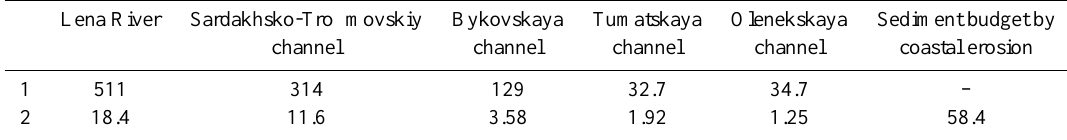
Table 1. Mean-annual water (1) (km 3 ) and sediment load discharge (2) (10 6 tyr − 1 ) by the Lena River and the main arms of the Lena delta (Antonov, 1987; Ivanov et al., 1999) and sediment budget by coastal erosion (2) (10 6 tyr − 1 ) on the shelf of Laptev Sea (Stein et al., 2004). Lena River Sardakhsko-Trofimovskiy Bykovskaya Tumatskaya Olenekskaya Sediment budget by channel channel channel channel coastal erosion 1 511 314 129